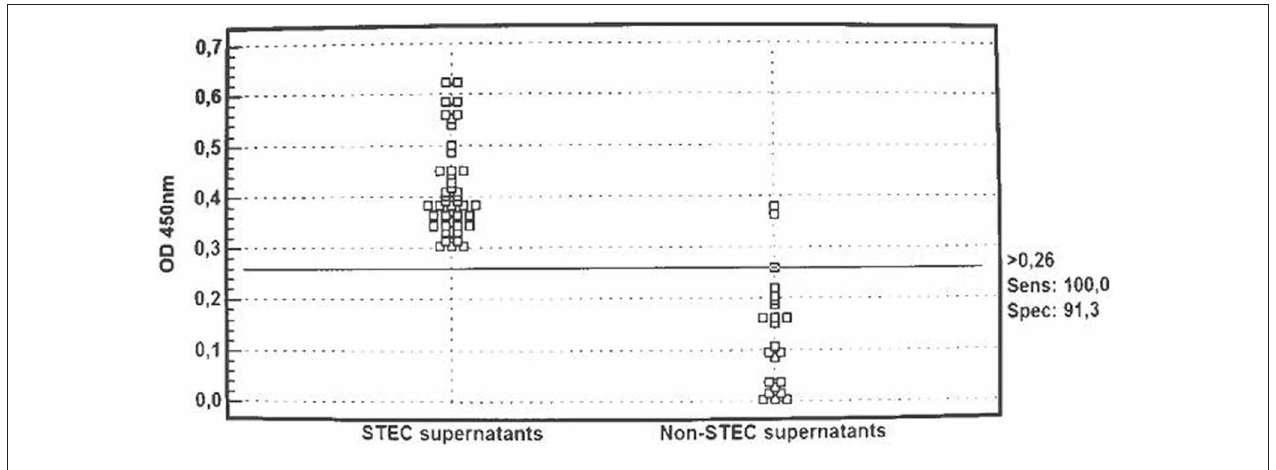
FIGURE 3 | Interactive dot diagram (MedCalc Stadistical Software). In the graph the data of the Stx-positive and Stx-negative strains are displayed as dots on two vertical axes. A horizontal line indicates the cut-off